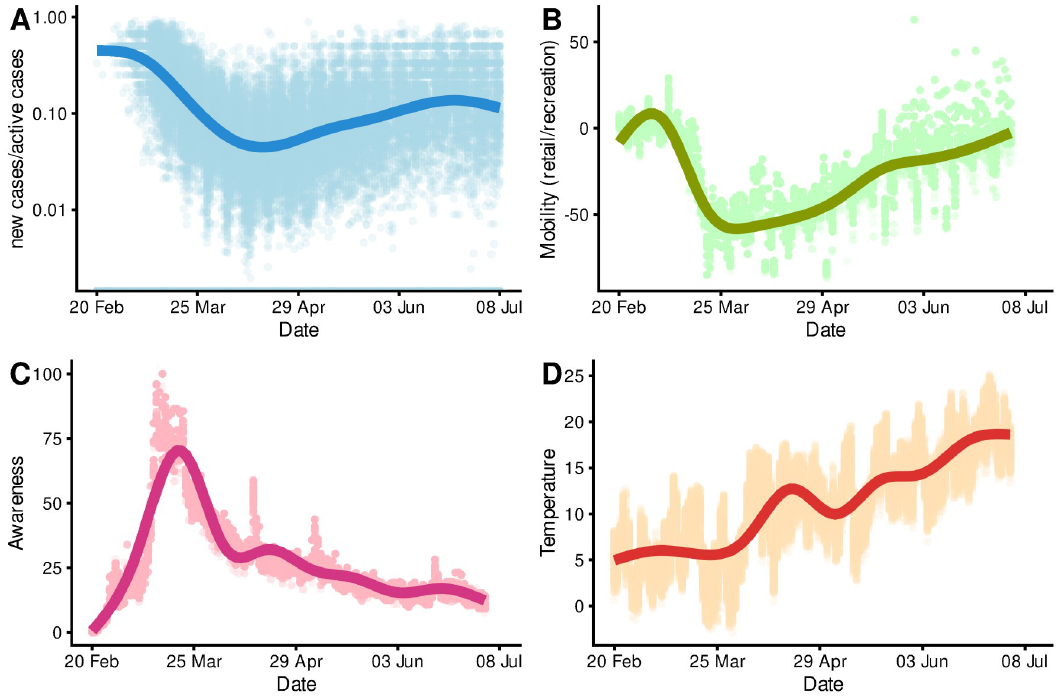
Fig 3. Temporal variation of outcome and main